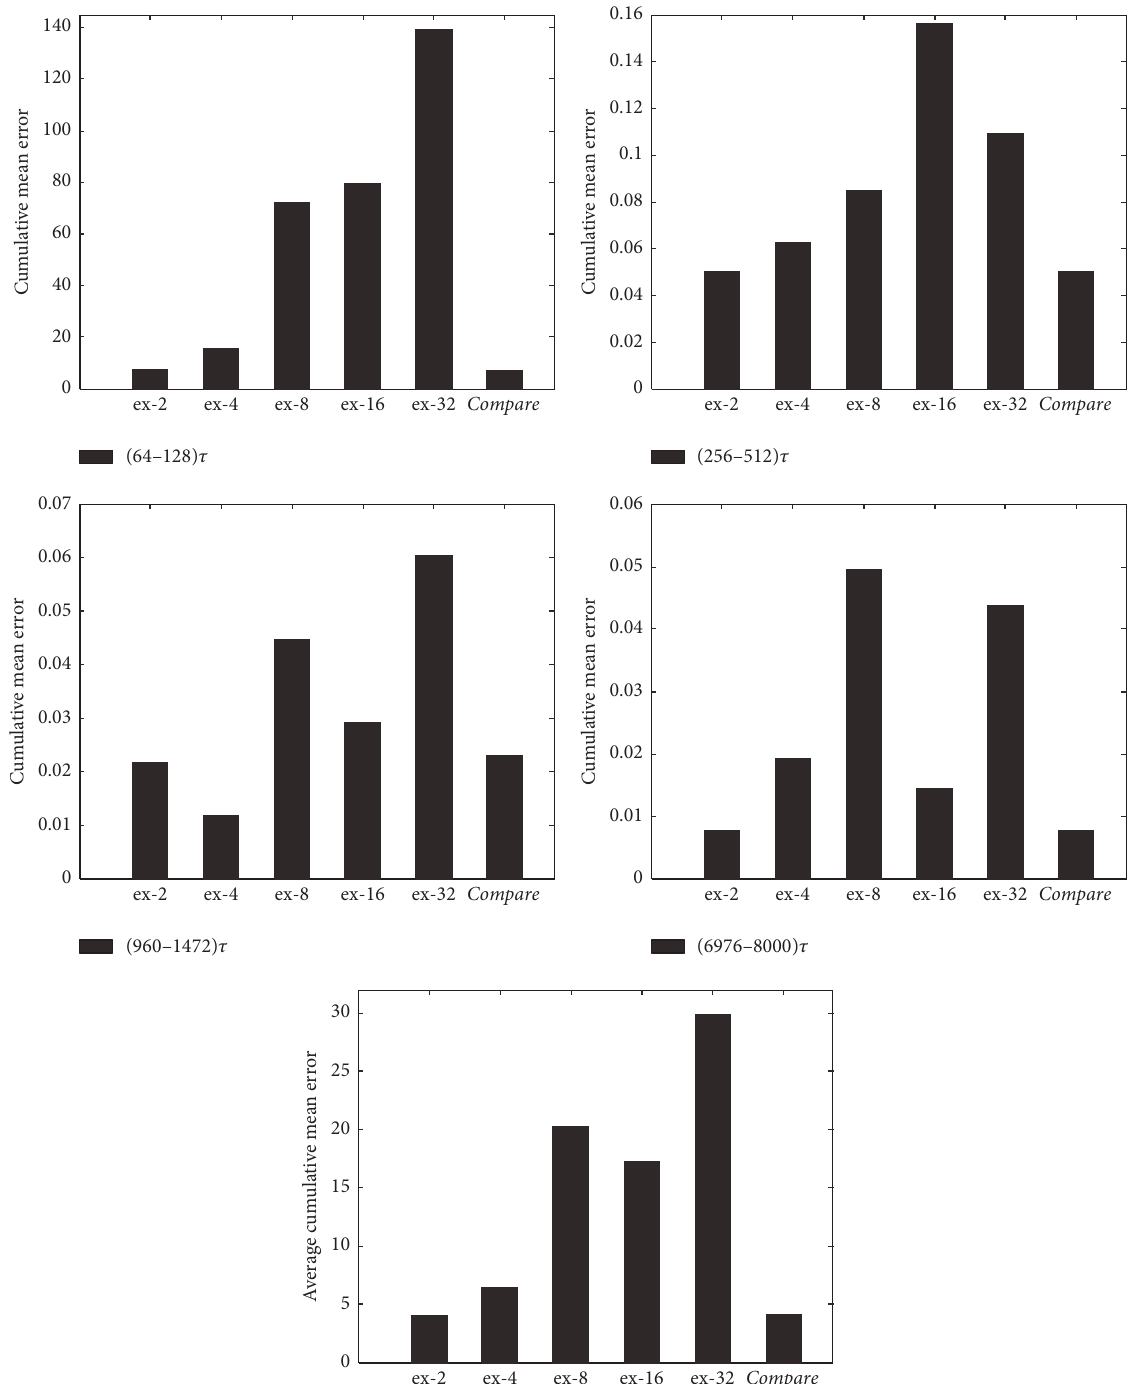
Figure 14: Cumulative mean errors during four time intervals (64–128) 𝜏 , (256–512) 𝜏 , (960–1472) 𝜏 , and (6976–8000) 𝜏 and final average